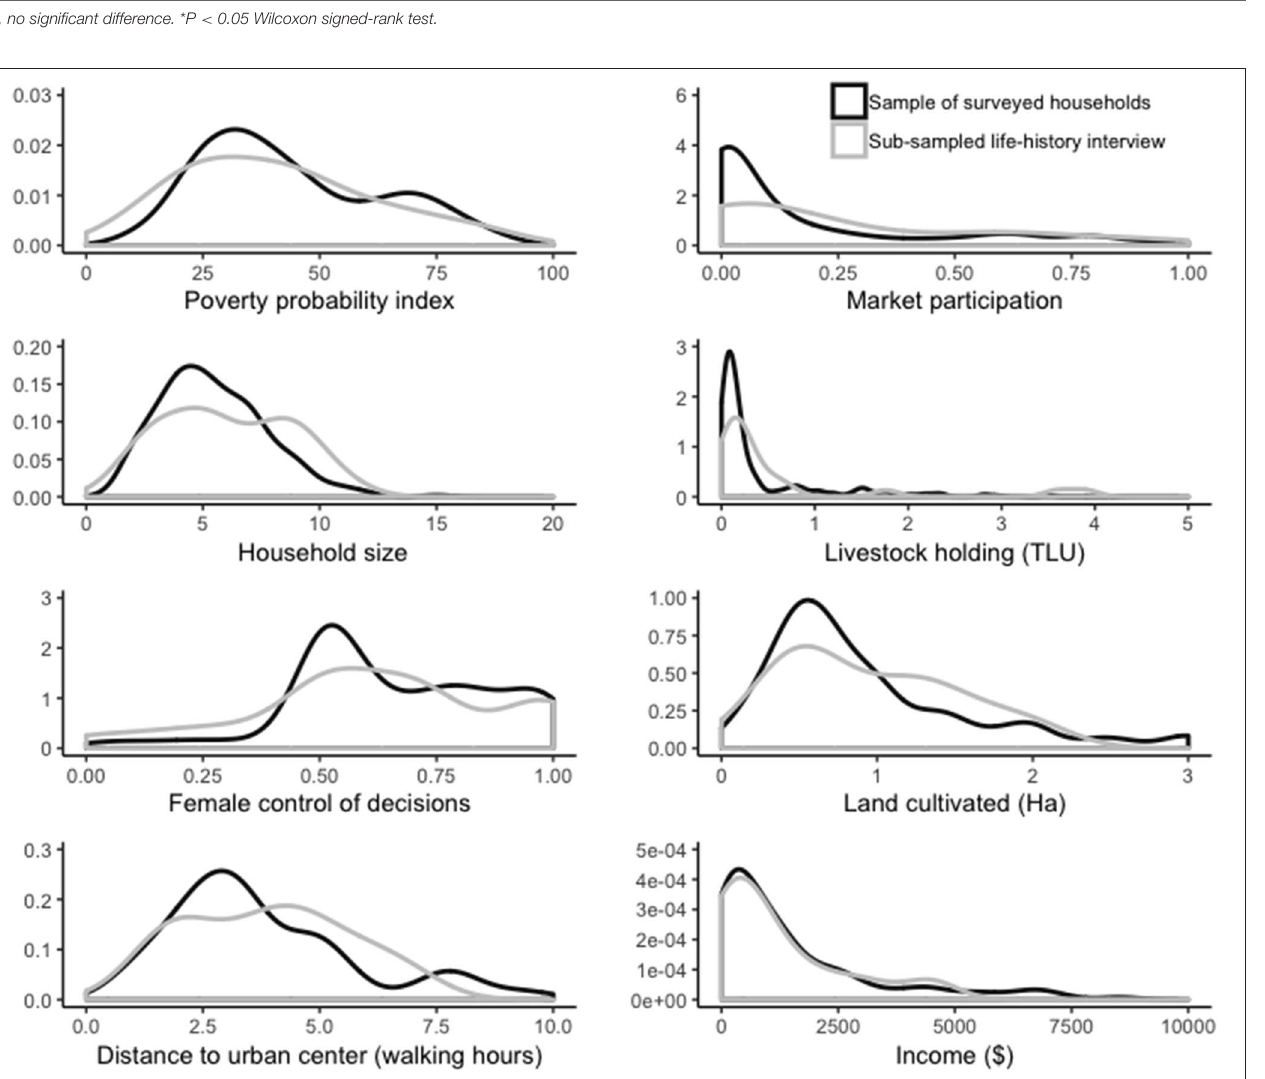
that livelihood change. Interview transcripts were first